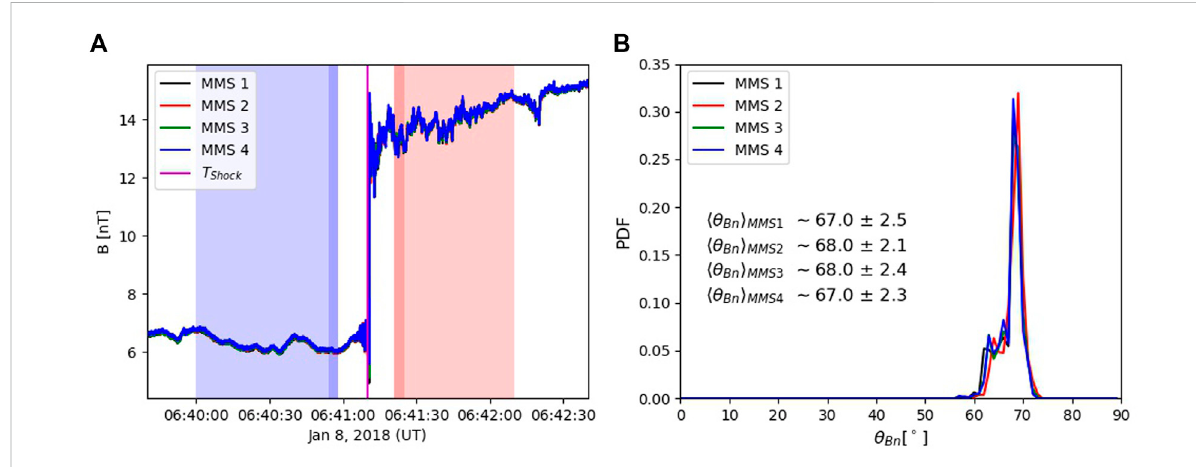
FIGURE 8 (A) :Magnetic fi eldmagnitudeobservedbythefourMMSspacecraftof8January2018.Thepurplelinerepresentsthetimeoftheshockcrossing. (B) : PDF distributions of θ Bn values obtained with the magnetic coplanarity method for each